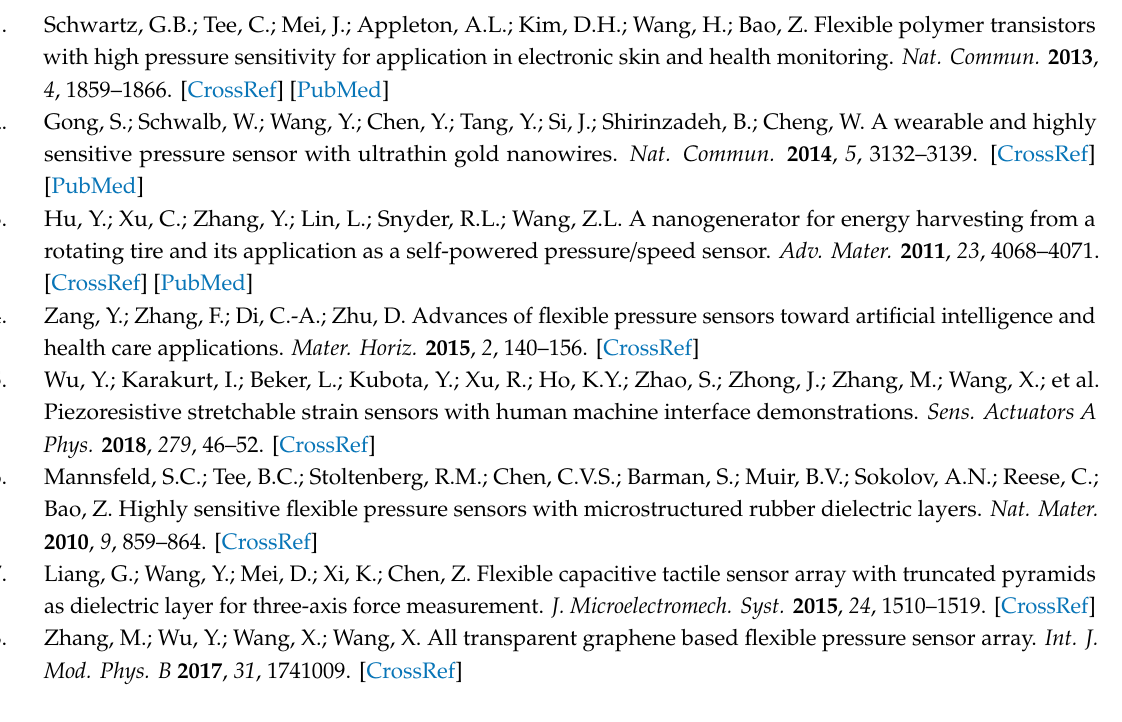
Figure S1: The measurement of stress-strain curve for 10:1 PDMS, Figure S2: (a) Single pyramid microstructure capacitive sensor, (b) boundary conditions of the model, (c) the nonlinear mesh grid at the tip of the pyramid. Where b p is the width of the micro-pyramid, l p is the side length of the square electrode plate, h p is the electrode